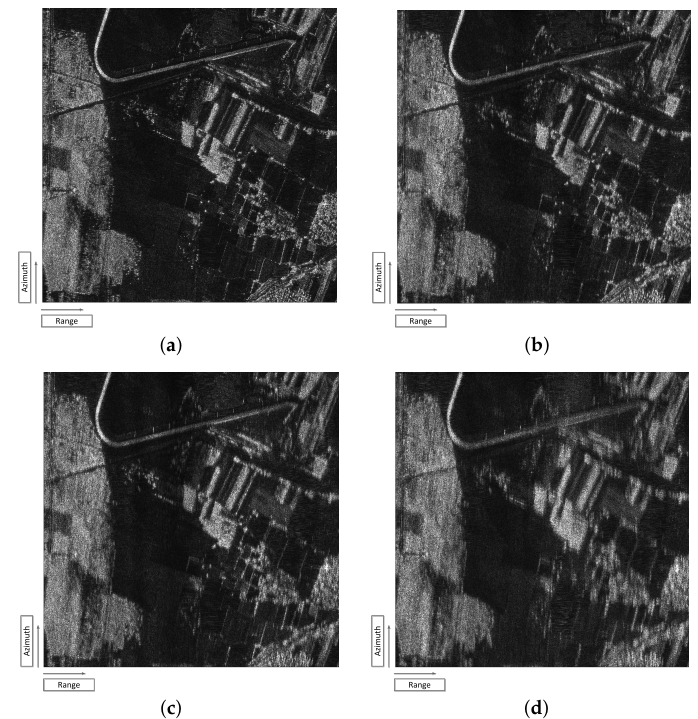
Figure 13. The simulation results of extended target. ( a ) Original SAR image. ( b ) Scintillation imaging result for p = 3. ( c ) Scintillation imaging result for p = 4. ( d ) Scintillation imaging result for p =